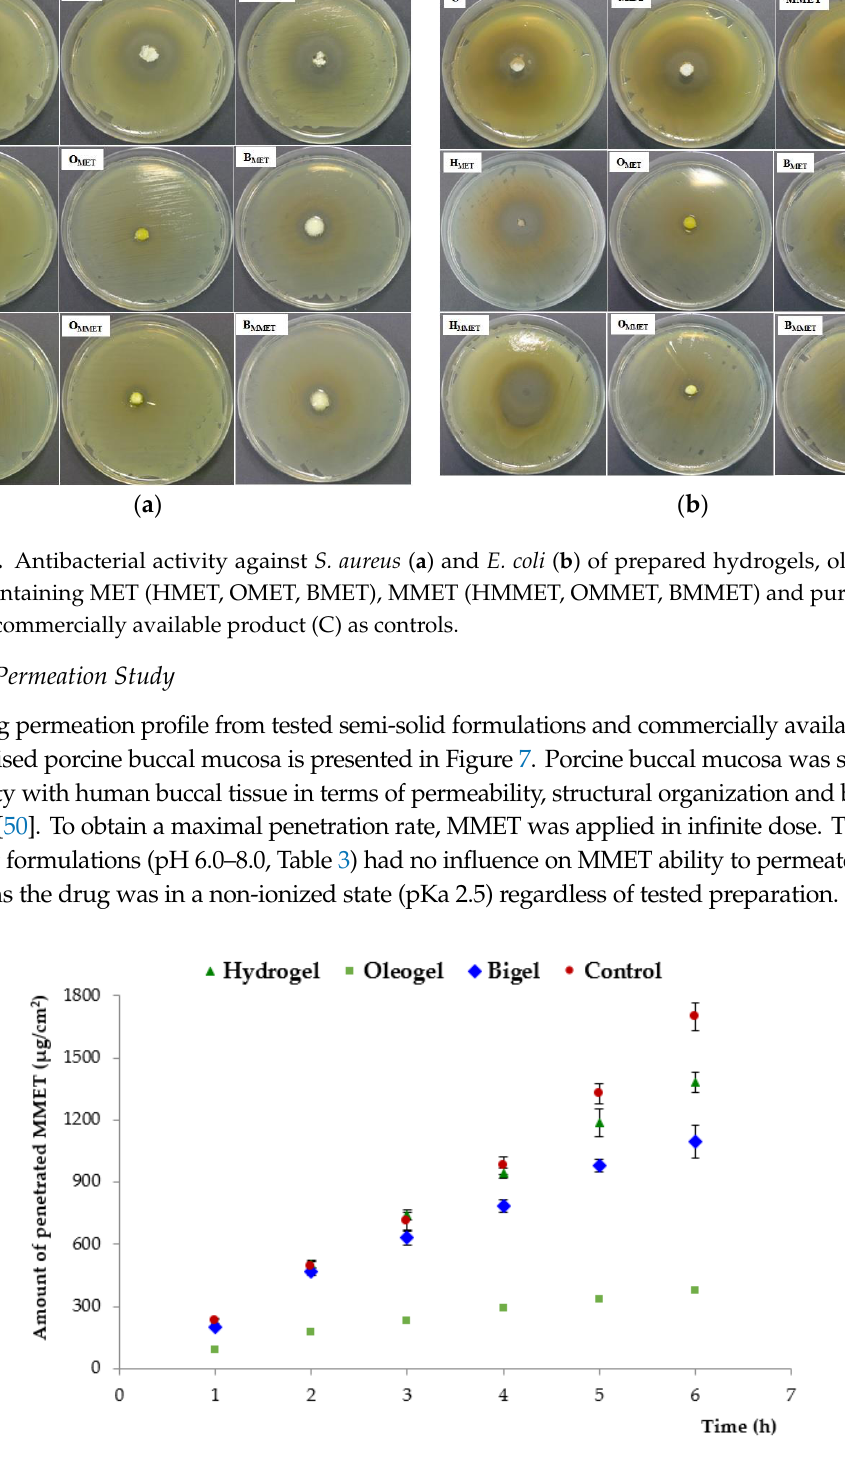
Figure 6. Antibacterial activity against S. aureus ( a ) and E. coli ( b ) of prepared hydrogels, oleogels, bigels containing MET (HMET, OMET, BMET), MMET (HMMET, OMMET, BMMET) and pure MET, MMET, commercially available product (C) as controls.